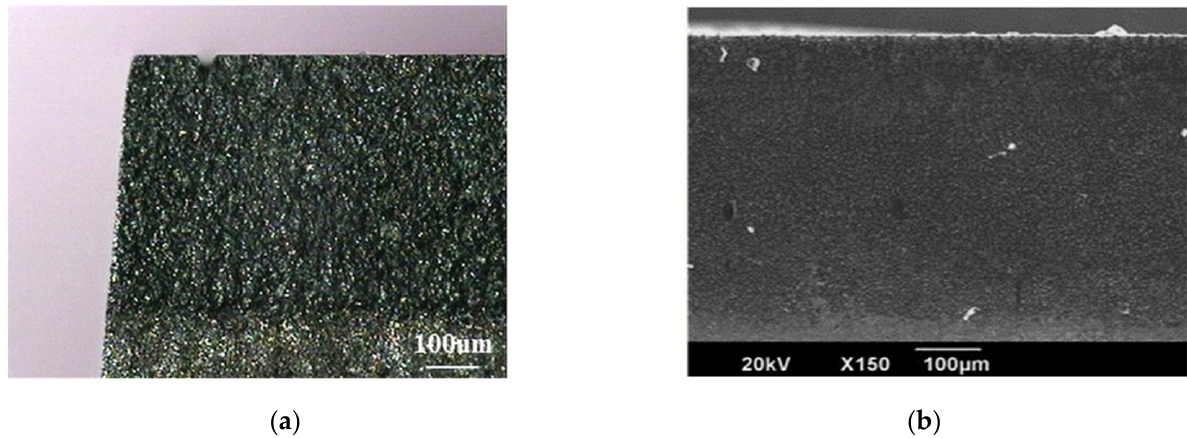
Figure 16. Optical microscope image ( a ) and SEM morphology ( b ) of the laser-finishing surface of the PCD workpiece by Method 3, using a pulse width of 200 ns and pulse repetition rate of 30 kHz.